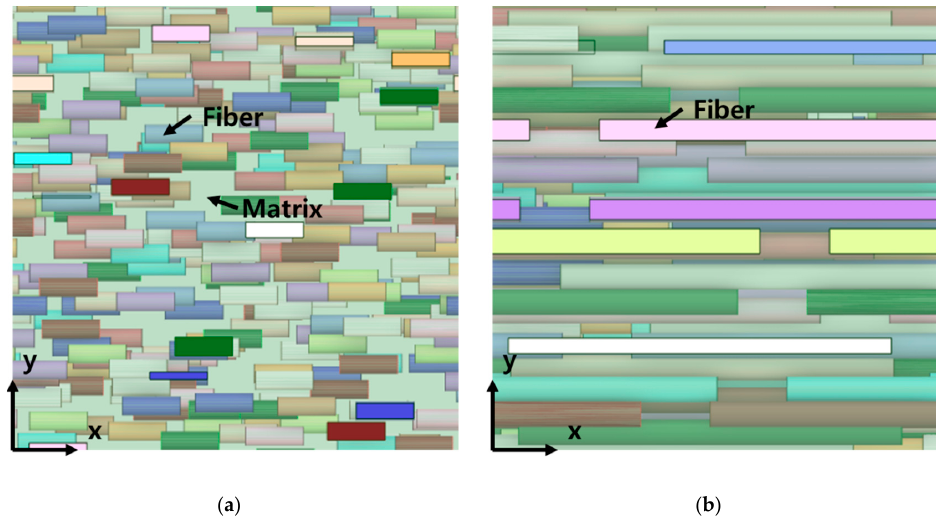
Figure 9. x–y cross section of 3D model based on the volume fraction and aspect ratio, ( a ) VF5%— Aspect ratio 3, ( b ) VF25%—Aspect ratio 15.